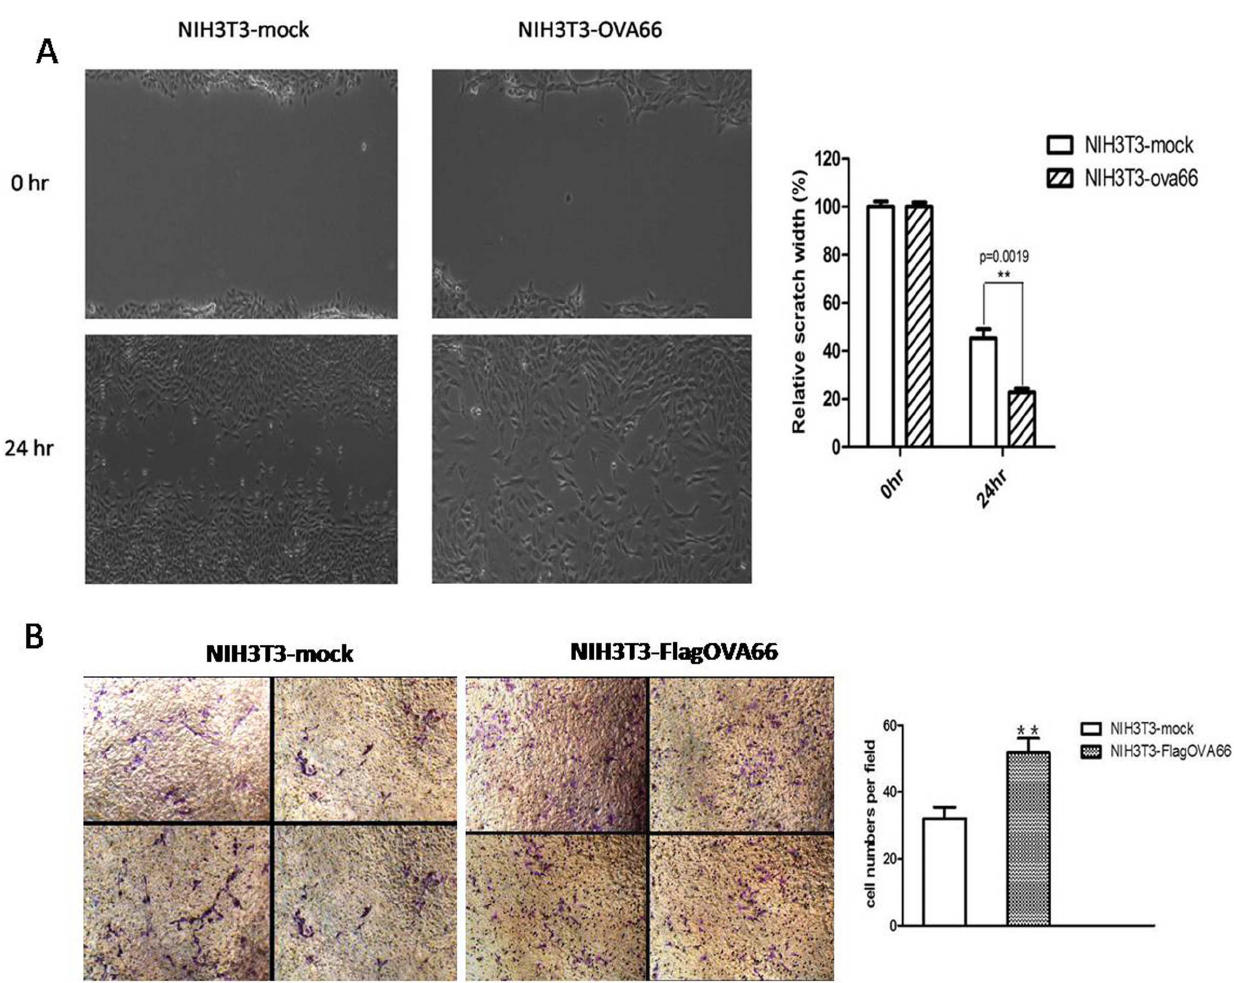
Figure 3. Cell migration assay. A. Assay of NIH3T3-mock and NIH3T3-flagOVA66 cell migration capacity by monolayer wound healing. Magnification: 100 6 . The relative scratch width(%) means the width at 24 hr/the width at 0 hr. The data represent mean 6 SEM (n=3), ** P # 0.01 B. Assay of transfected NIH3T3 cell migration capacity by transwell migration assay in vitro . The polycarbonate were stained with Crystal violet and inspected under a microscope at 200 6 . The Column means the number of cells that migrated the Transwell membranes, the data are represented as mean 6 SEM, ** P # 0.01.